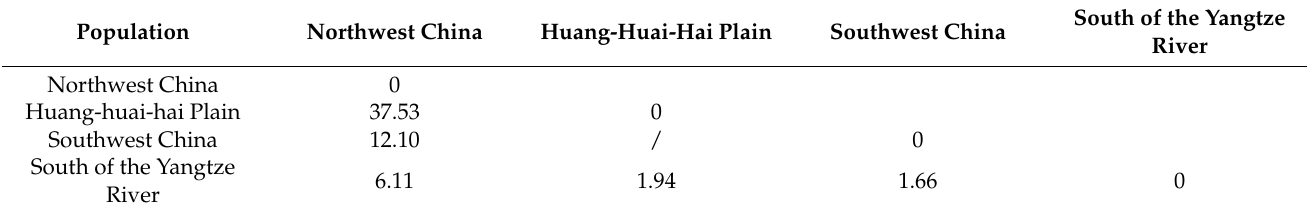
Table 5. Gene flow index ( Nm ) of different populations.